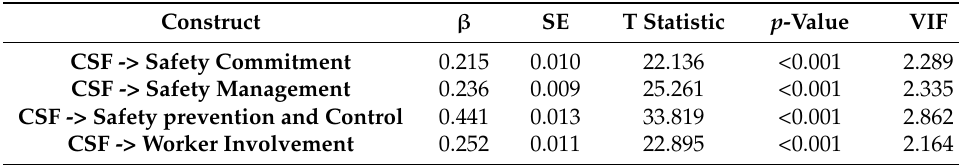
Table 7. Test of second-order formative models using